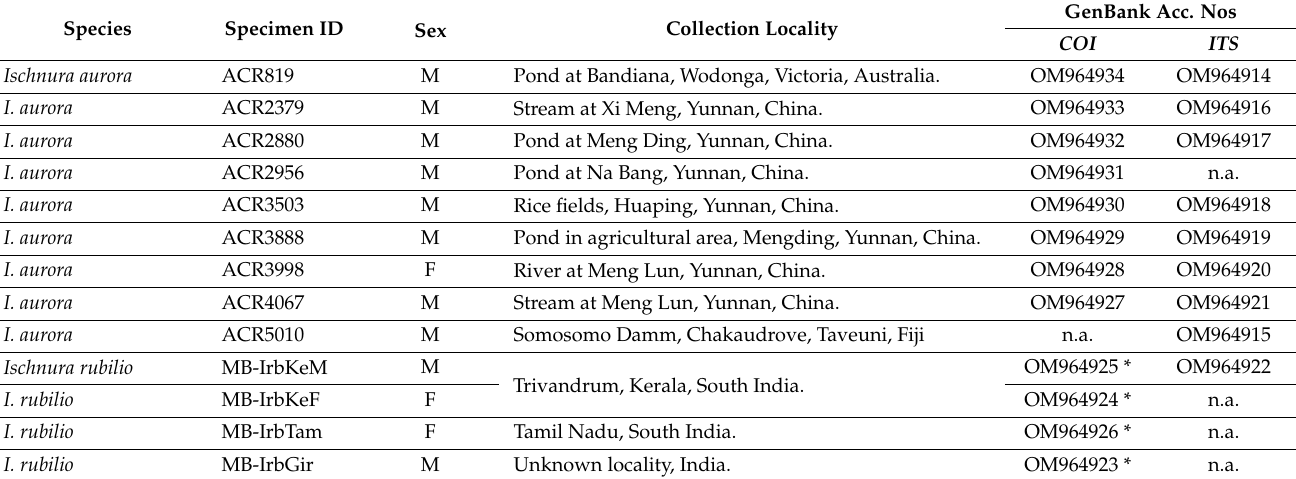
Table 1. Information on Ischnura aurora and I. rubilio specimens used for DNA extraction and sequencing as described in the main text. For each specimen, we list the voucher ID, sex, and collection locality. n.a. indicates that no sequence could be obtained for a particular marker and/or specimen; Accession numbers labelled with an asterisk are those that correspond to sequences annotated as COI -like sequences (see Appendix A and Table